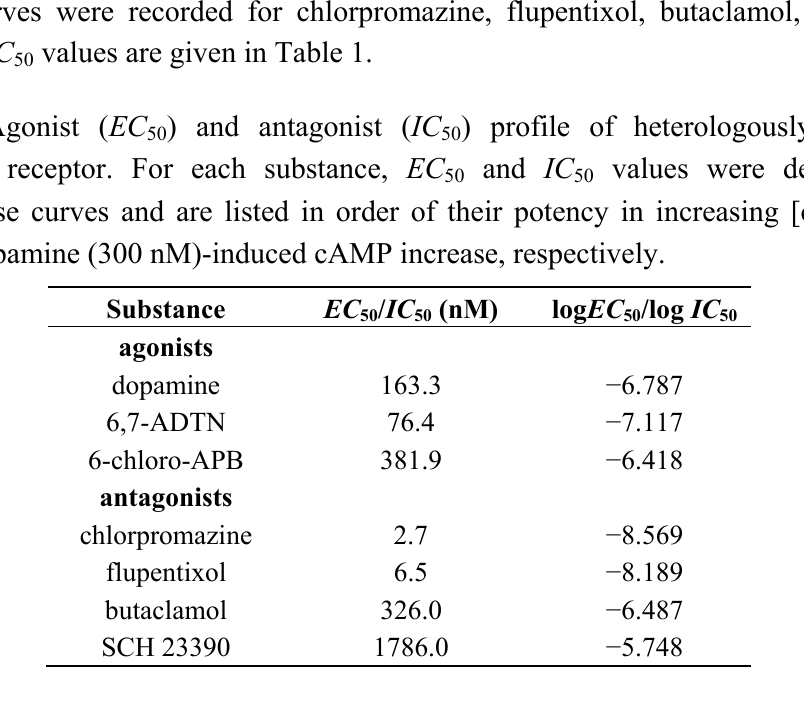
) and antagonist ( IC ) profile of heterologously expressed 50 50 and IC values were derived from 50 50 and i